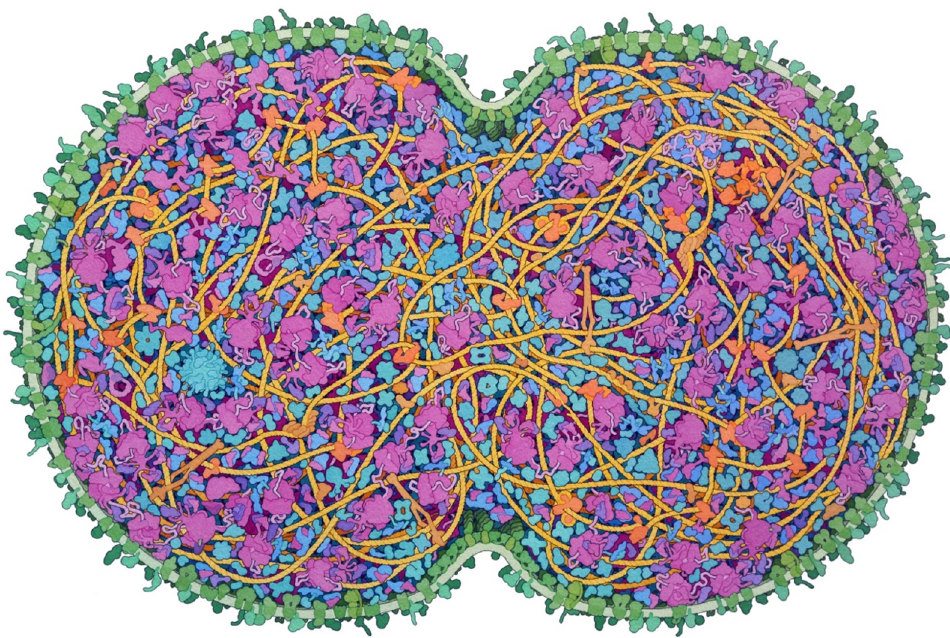
Figure 1: Artistic conception of a cross-section through a dividing JCVI-syn3A cell. Small molecules, ions, and water are omitted for